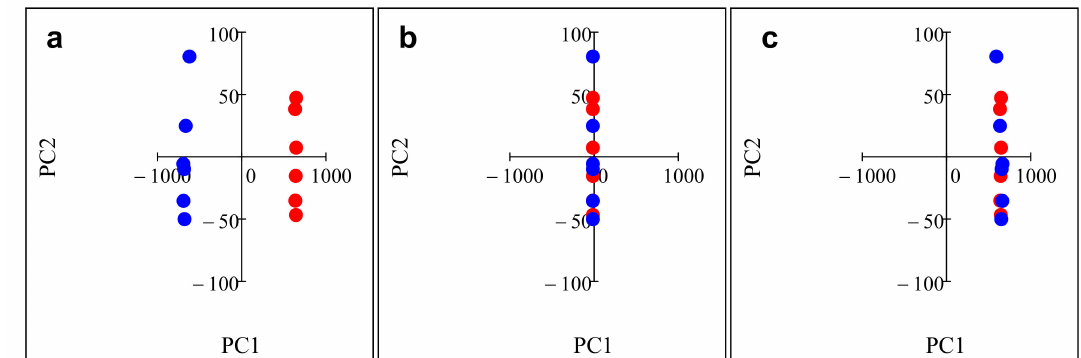
Figure 1. Principal component analysis plots demonstrating component correction for citric acid week 0 (red points) and week 1 (blue points). ( a ) original data and ( b ) component correction and ( c ) modified component (correction subtracting twice the drift from week